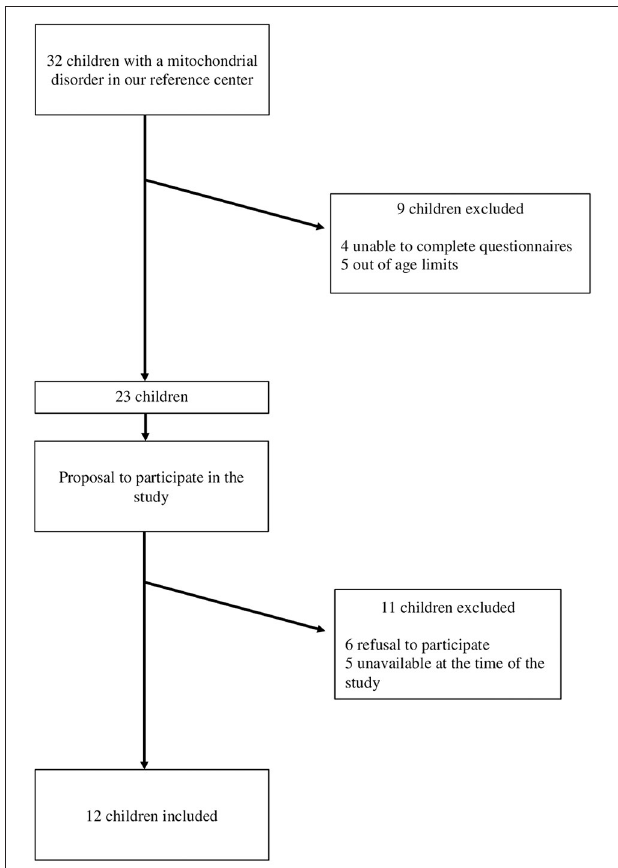
FIGURE 1 | Study flow